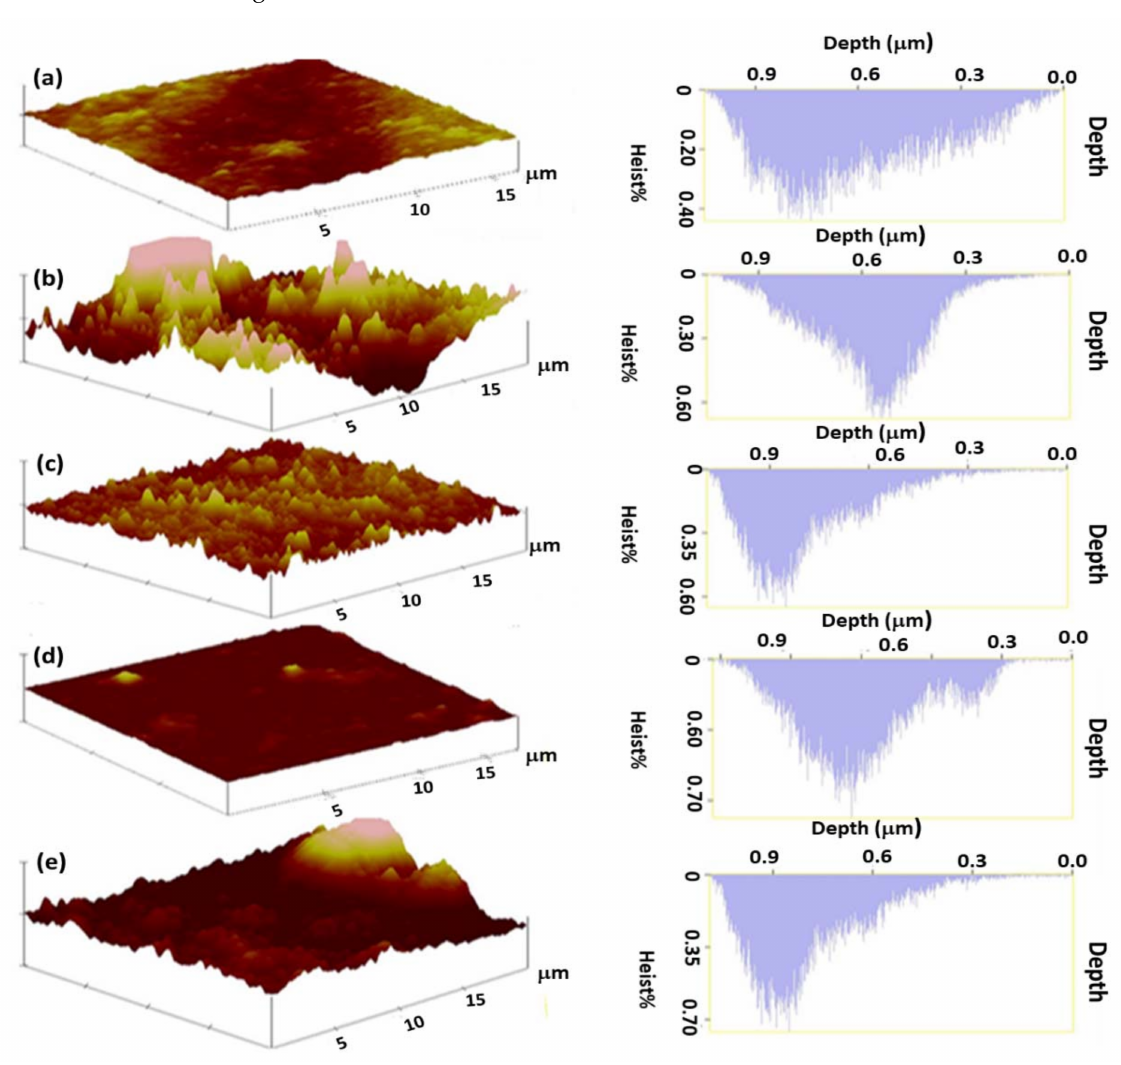
Figure 4. AFM images of: ( a ) unmodified PA–TFC membrane; and membranes modified with: ( b ) 1.00% AA, ( c ) 0.50:1.00% ZnO/AA, ( d ) 1.50% AA, and ( e ) 0.50:1.50%